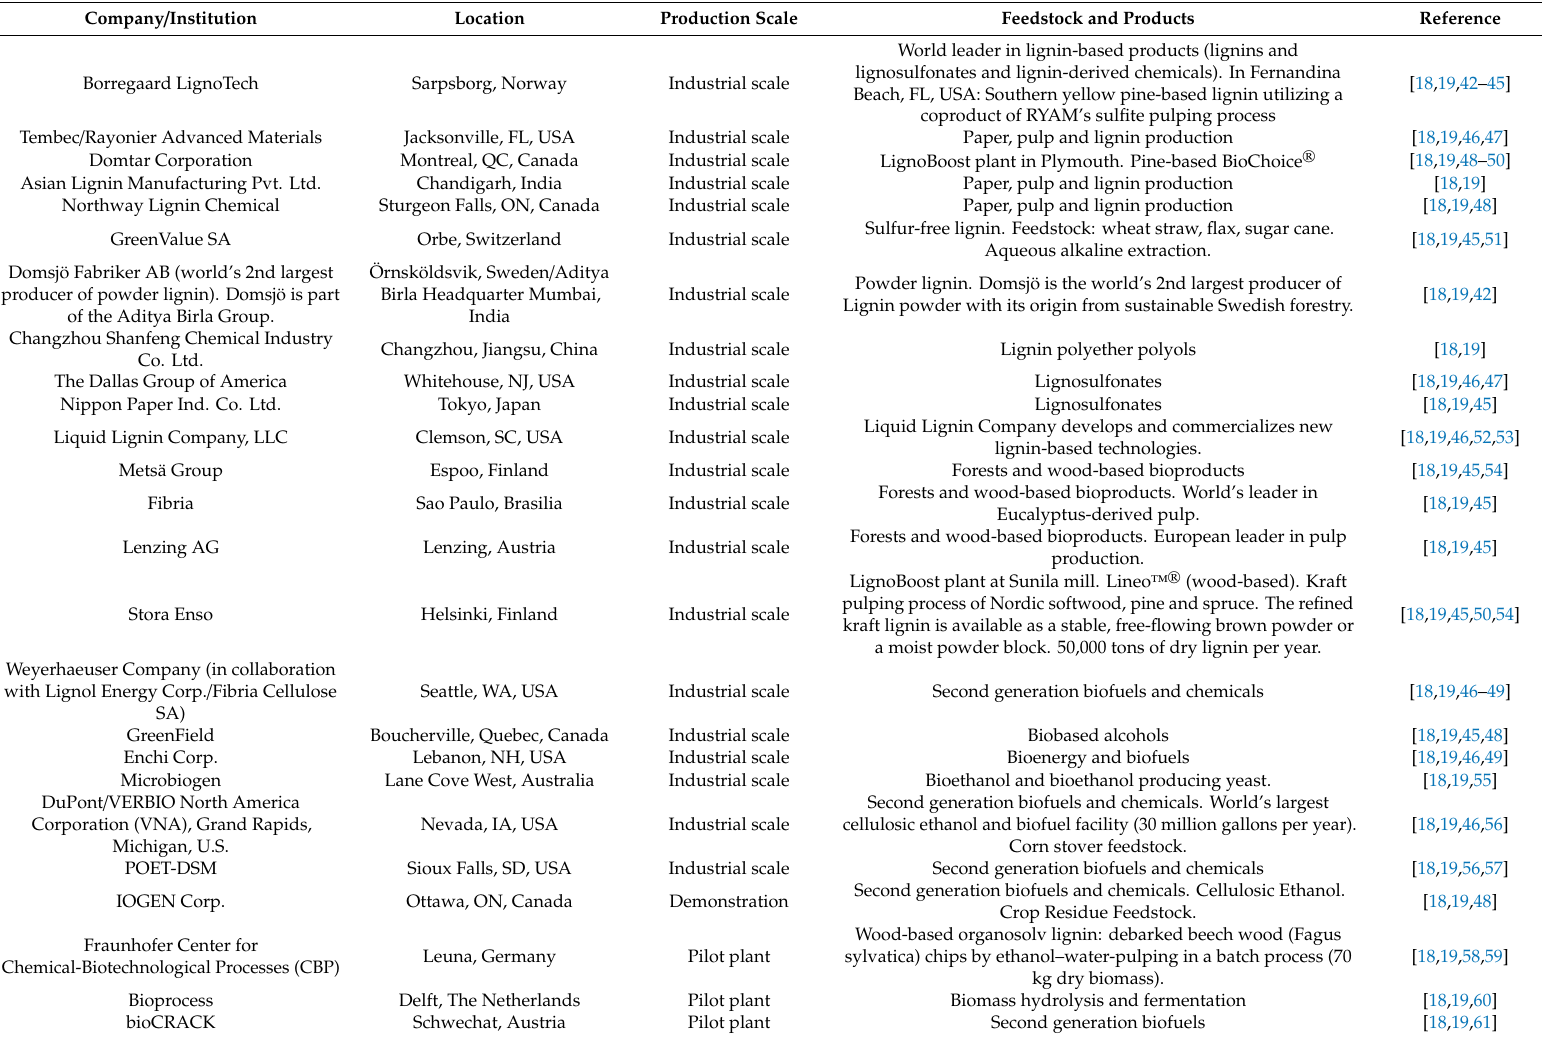
Table 2. Pilot plants and industrial production sites for lignocellulose feedstock (LCF) exploitation and valorization